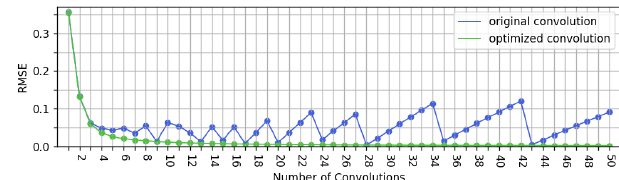
Figure 8. Root mean square error with respect to the exact Barnes interpolation in dependency of the number of performed convolu- tions for both the original and the optimized convolution algorithms.